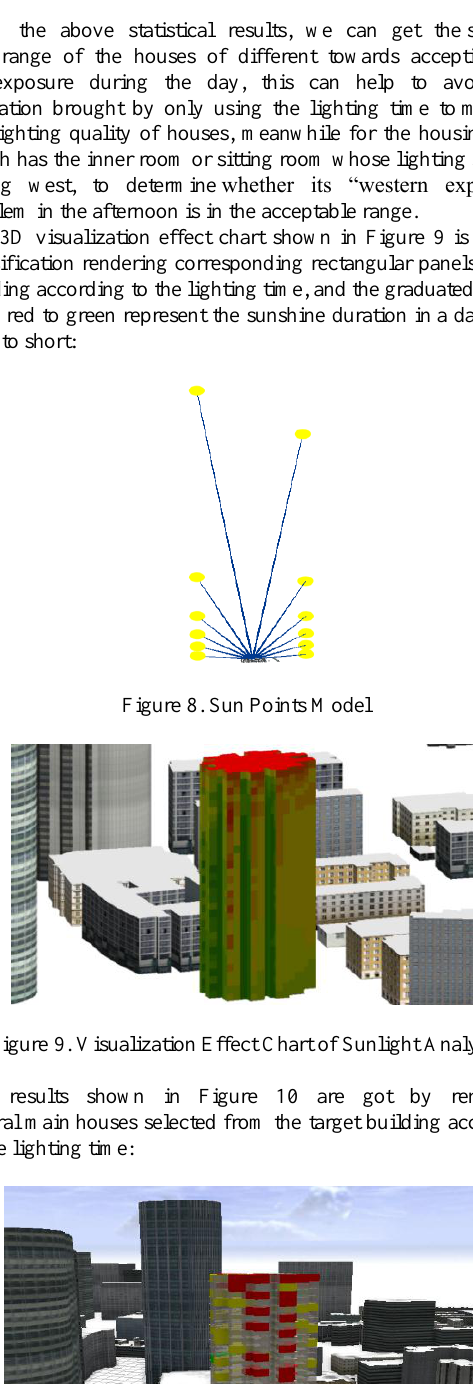
Figure 7. Visibility Graphs Between the Houses of Different Towards And the Sun